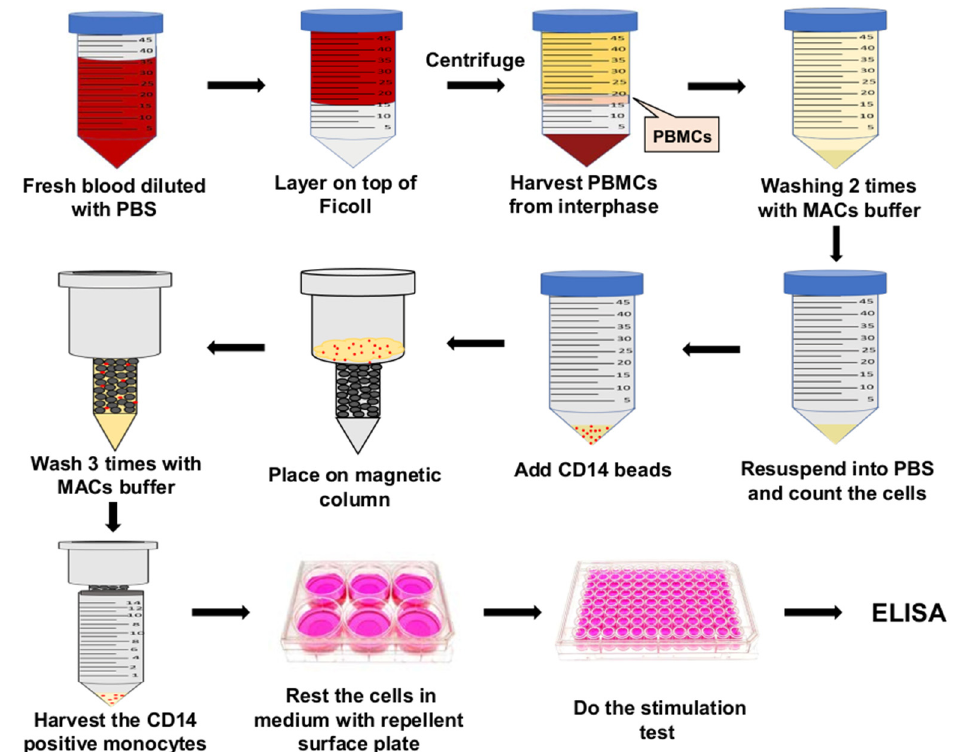
Figure 5. Flow chart of the human monocyte isolation procedure and stimulation with lipopeptides. Fresh blood from human volunteers is first processed over a Ficoll gradient. Monocytes are then purified from the PBMC layer by bead CD14 + affinity using magnetic separation technique and allowed to rest for 24 h in a repellent-surface-equipped plate. Subsequently, non-activated and pure monocyte populations are used for cytokine production upon lipoprotein stimulation. For further details, please refer to Materials and Methods.